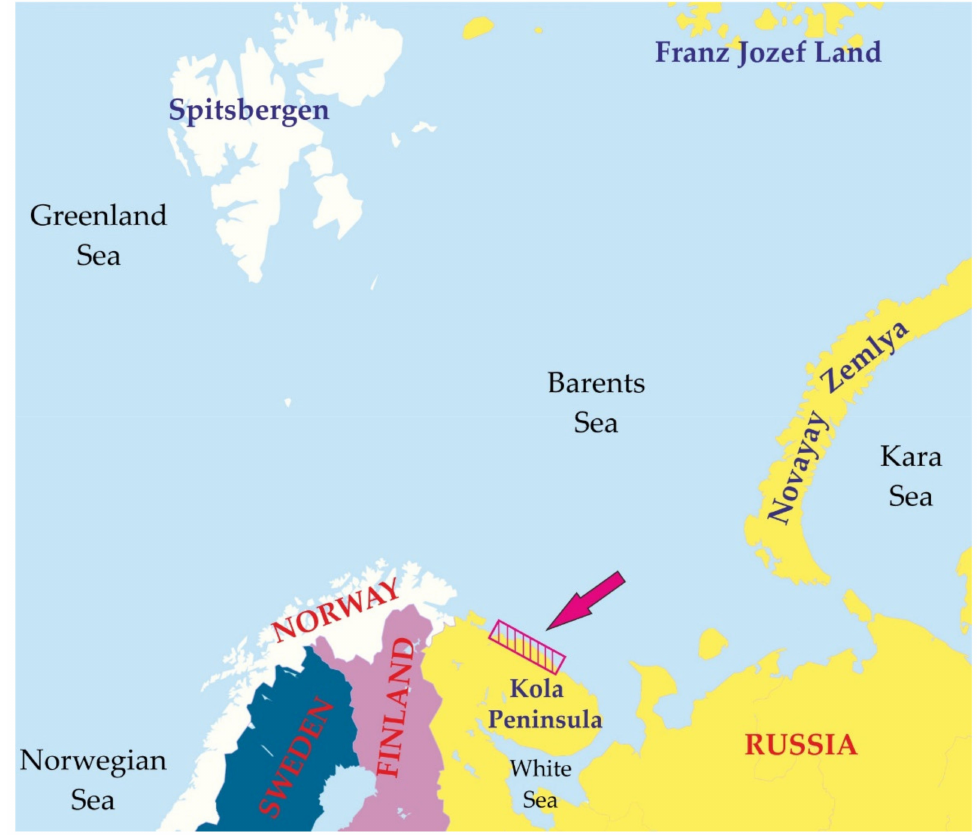
Figure 1. Study area in the southern Barents Sea. Radioimmunoassays were carried out according to the protocols suggested by the manufacturer (A Beckman Coulter Company, Villepinte, France) using Immunotech RIA Testosterone or Immunotech RIA Estradiol test kits. In the case of testosterone, a 50- µ L hemolymph sample and 500 µ L of 125 I-labelled testosterone were added serially to an antibody-coated tube. In the case of 17 β -estradiol, a 100- µ L hemolymph sample was used in the assays. A tube containing 500 µ L of 125 I-labelled testosterone (or estradiol) was included in every assay to determine the total 125 I-activity (the sample “T”). The “testosterone” tubes were incubated at 37 ◦ C in a waterbath for 3 h while the “estradiol” tubes were incubated with constant shaking (350 rpm) at ambient temperature for 3 h. At the end of incubation, the radioactivity of samples was determined using a scintillation counter (ARIAN, producer OOO VITAKO, Moscow, Russia). The standard graphs were plotted and the concentrations of testosterone and 17 β -estradiol were obtained from the standard plot. The results were multiplied by a dilution factor of 3.33. The analytical sensitivity of the testosterone kit was 0.025 ng mL –1 , the working RIA range was 0.025 − 20 ng mL –1 , the coefficient of variation between samples was 14.8%. For the estradiol kit, these levels were <6 pg mL –1 , 6 − 5000 pg mL –1 and 12.1%, respectively. Carapace lengths and weight data in male and female red king crabs were compared using a one-way analysis of variance (ANOVA) or non-parametric Kruskal–Wallis tests in the case of non-normal data distribution. Since the sex hormone data were not nor- mally distributed and failed testing for homogeneity of variances (modified Levene’s test, p < 0.05), testosterone and 17 β -estradiol concentrations in relation to crab sex, crab size, and sampling season were compared using the Kruskal–Wallis test. When the